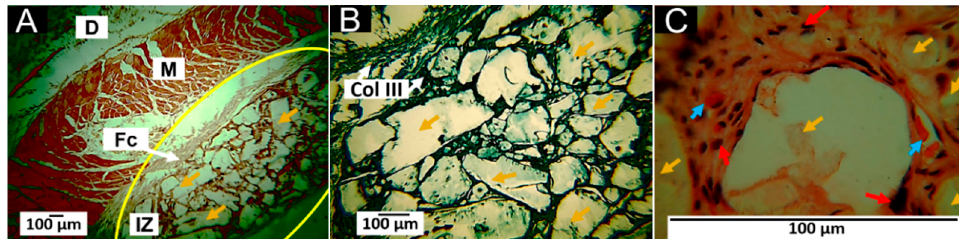
Figure 13. Subdermal implants of F3 (15%PCL/70%PLA/5%Gly/10%TTEO) at 60 days. ( A ): Formulation F3 at 4× HE technique. ( B ): Formulation F3 at 10× GT technique. ( C ): Formulation F3 at 100× HE technique. Yellow oval: Implantation zone. D: Dermis. M: Muscle. Fc: Fibrous capsule. IZ: Implantation zone. Col III: type III collagen. Yellow arrows: Fragments of material F3. Red arrows: Inflammatory cells. Blue arrows: Blood vessels. HE: Hematoxylin and Eosin technique. GT: Gomori Technique.